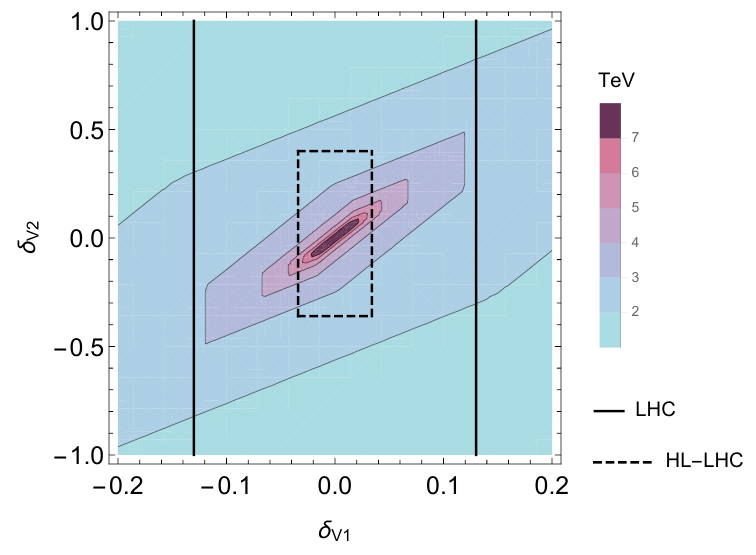
Figure 12 . Unitarity violating contours from δ V 1 and δ V 2 . The solid lines represent the ATLAS bound on δ [30] while the δ bound [35] is outside of the plot range. The dashed lines show the V 1 V 2 projected bounds for δ [24] and δ at HL-LHC, where the δ bounds are the 95% C.L. bounds V 1 V 2 V 2 from doubling the 68% bounds from a projected vector boson fusion di-Higgs search